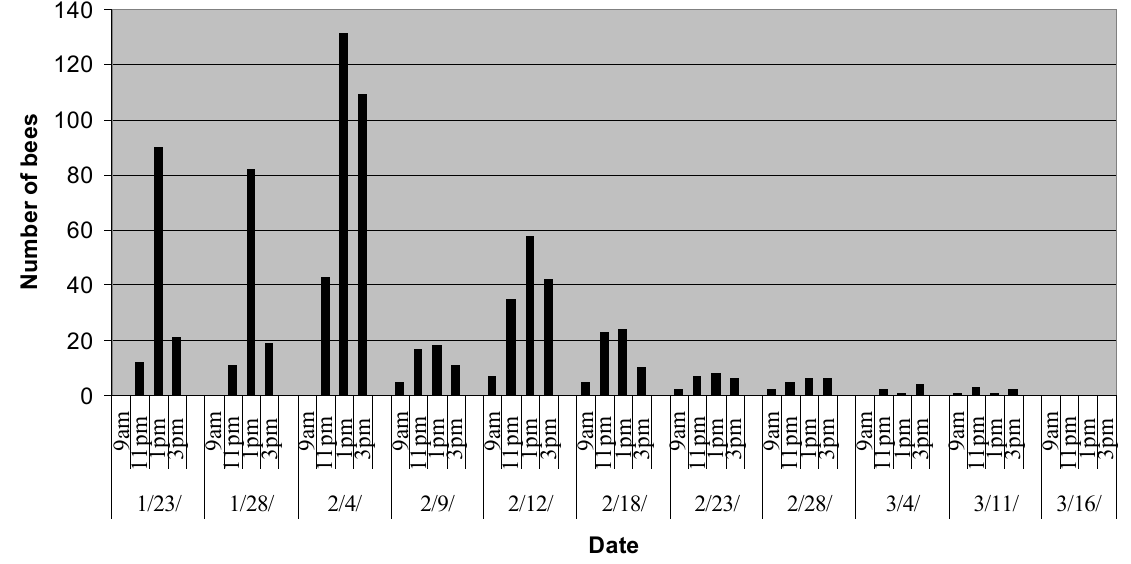
Fig 3 . Seasonal and daily abundance of E. nigrilabris .